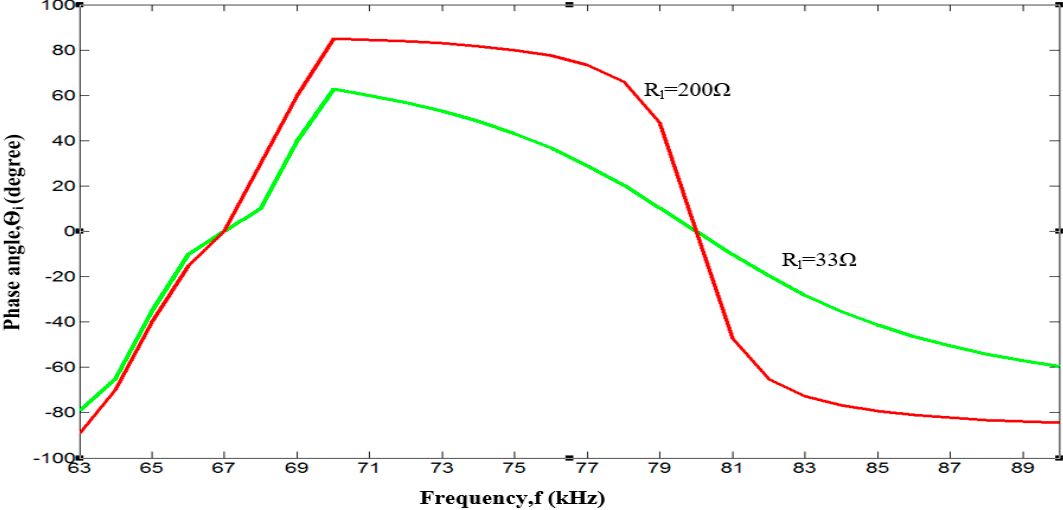
Figure 5. Measured input phase angle of the 500 W LC-LC2 compensated resonant converter.